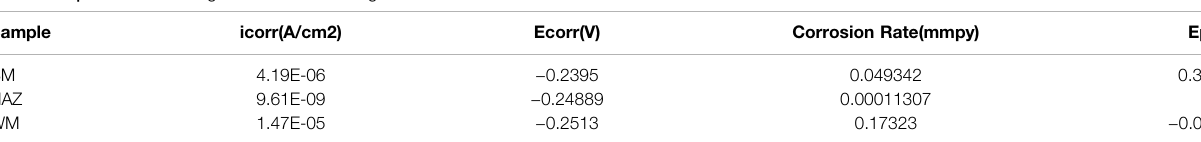
TABLE 12 | Polarization fi tting data of the three regions at 25 ° C.